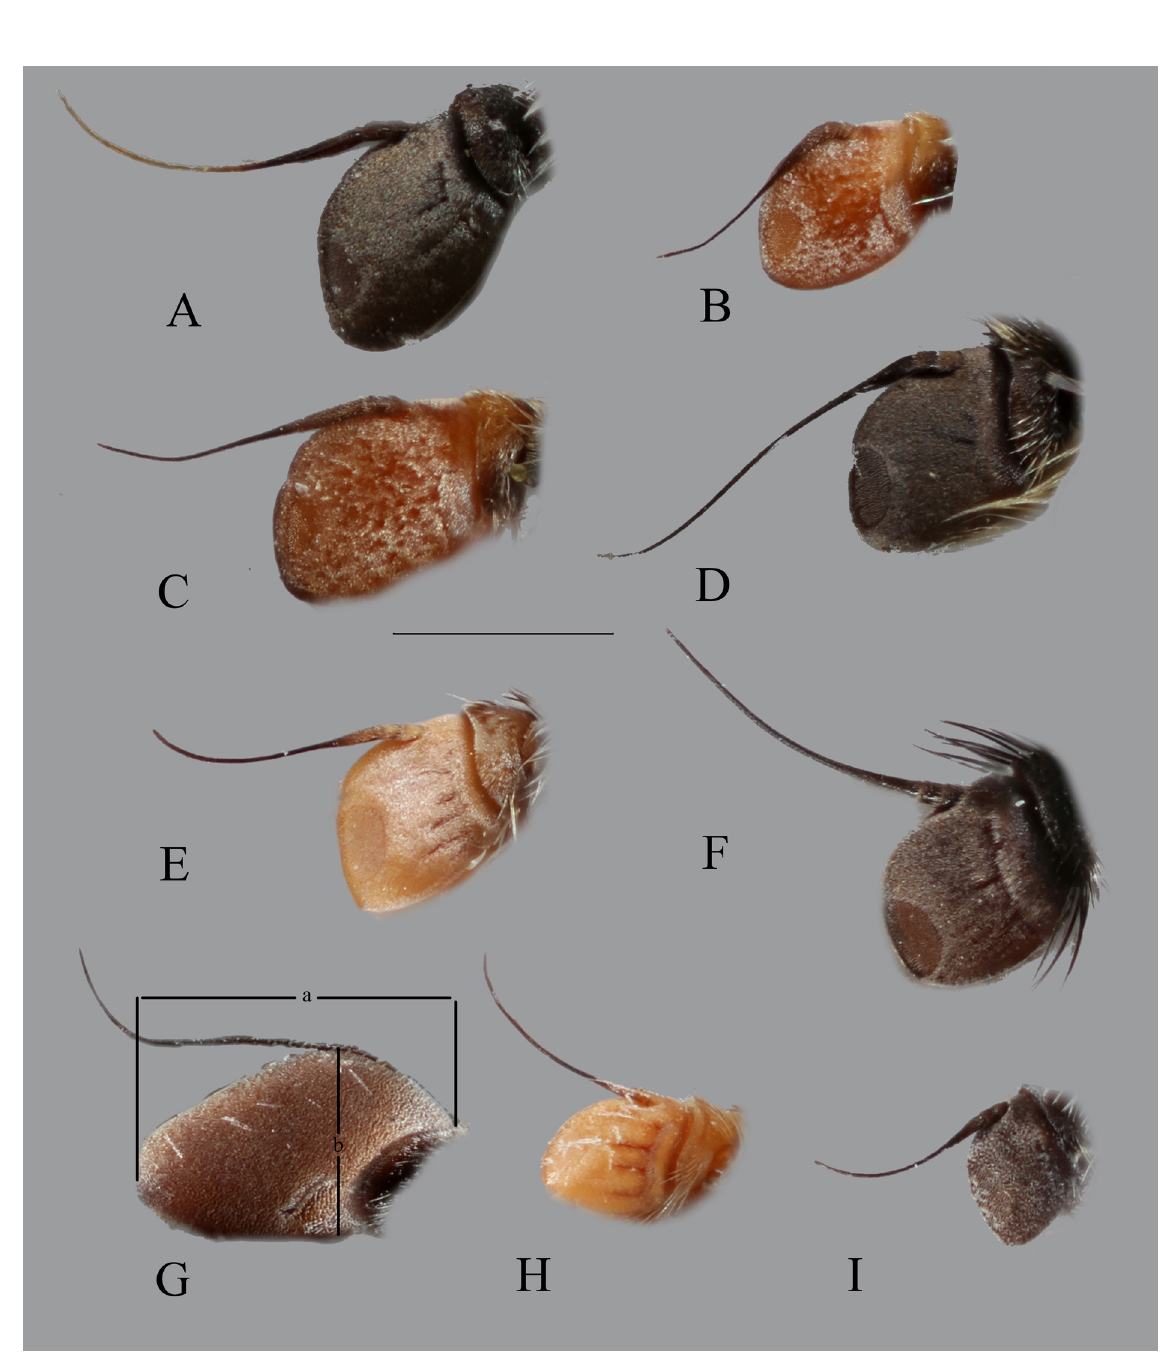
Fig. 11. Basoflagellomere, mediolateral view. A . Eumerus atricolorus Gilasian & van Steenis sp. nov., holotype, ♂ (HMIM). B . E. brevipilosus Gilasian & van Steenis sp. nov., holotype, ♂ (HMIM). C . E. brevipilosus Gilasian & van Steenis sp. nov., paratype, ♀ (HMIM). D . E. chekabicus Gilasian & van Steenis sp. nov., holotype, ♂ (HMIM). E . E. kazanovzkyae Paramonov, 1927, ♂, Paveh, Iran (HMIM). F . E. hissaricus Stackelberg, 1949, ♂, Ghoochan, Iran (HMIM). G . E. ovoformus Gilasian & van Steenis sp. nov., holotype, ♂ (HMIM). H . E. pilosipedes Gilasian & van Steenis sp. nov., holotype, ♂ (HMIM). I . E. vallicolus Gilasian & van Steenis sp. nov., holotype, ♂ (HMIM). Scale bars = 0.5 mm. Abbreviations: a = length of basoflagellomere; b = width of